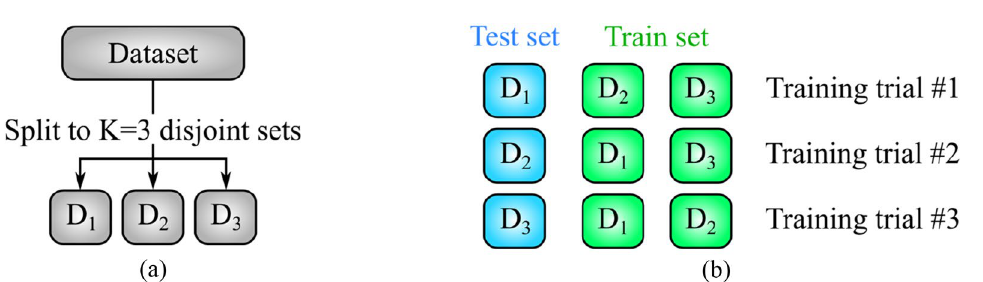
Figure 5. Process of building GBT according to given training set: each S i is the set of samples misclassified by ith decision tree.